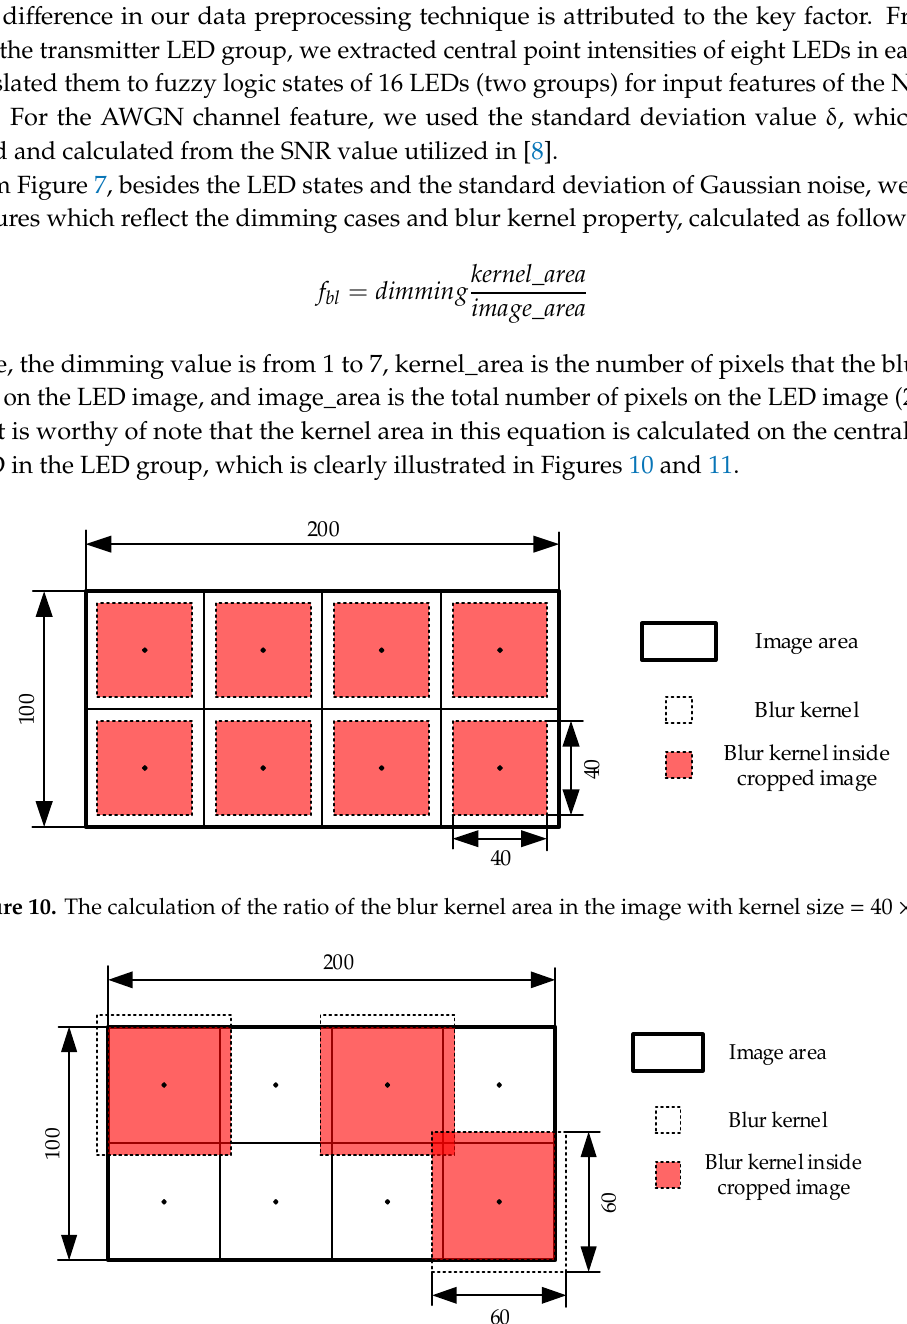
Figure 11. The calculation of the ratio of the blur kernel area in the image with kernel size = 60 × 60.